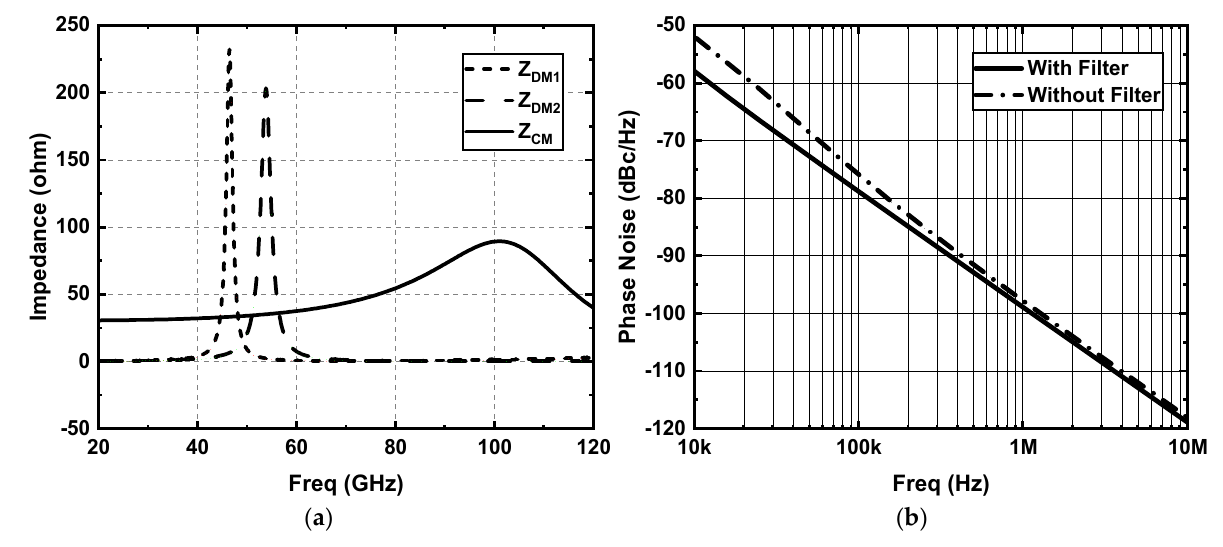
Figure 7. Simulated common-mode and differential-mode impedance and phase noise of the VCO: ( a ) The fundamental and second harmonic impedances over with the tuning range; ( b ) the simulated phase noise with and without the implicit second harmonic filter.